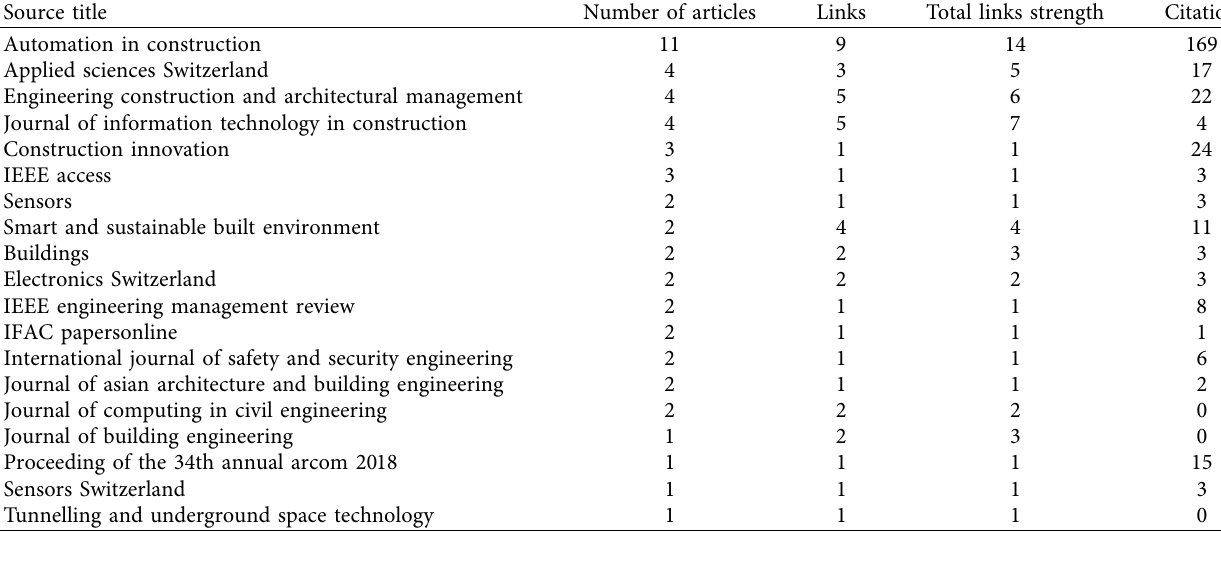
Table 2: Te AEC-FM industry’s sources’ quantitative measures concerning the digital research.